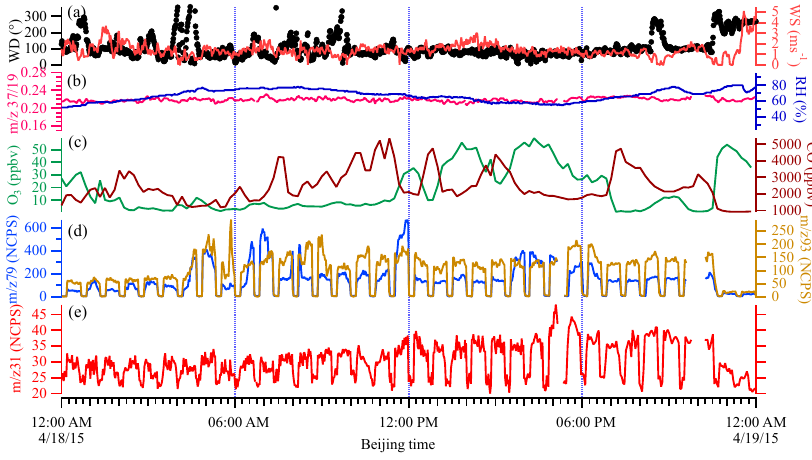
Figure 8. Time series of wind direction (WD) and wind speed (WS) (a) , m/z 37 / 19 ratio and RH (b) , O 3 and CO (c) , m/z 79 and m/z 93 (d) , and m/z 31 signal (e) on 18 April 2015. The dips in (d) and (e) are the periods when background checks were made.